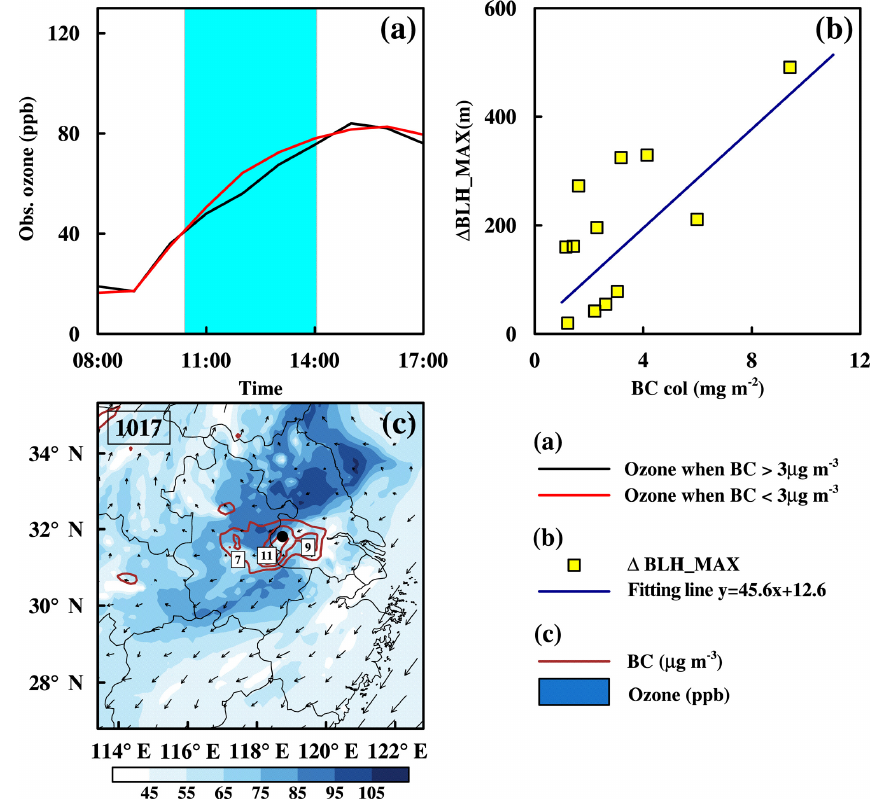
Figure 3. (a) Observational averaged ozone concentrations with BC concentrations lower (red) and higher (black) than the monthly mean value during October 2015. (b) Simulated maximum BLH changes (yellow squares) induced by BC. (c) Average distribution of surface BC (red contour) and ozone concentrations (blue color fill), showing wind fields from 10:00 to 14:00LT on 17 October 2015. Black dot denotes the location of the observation